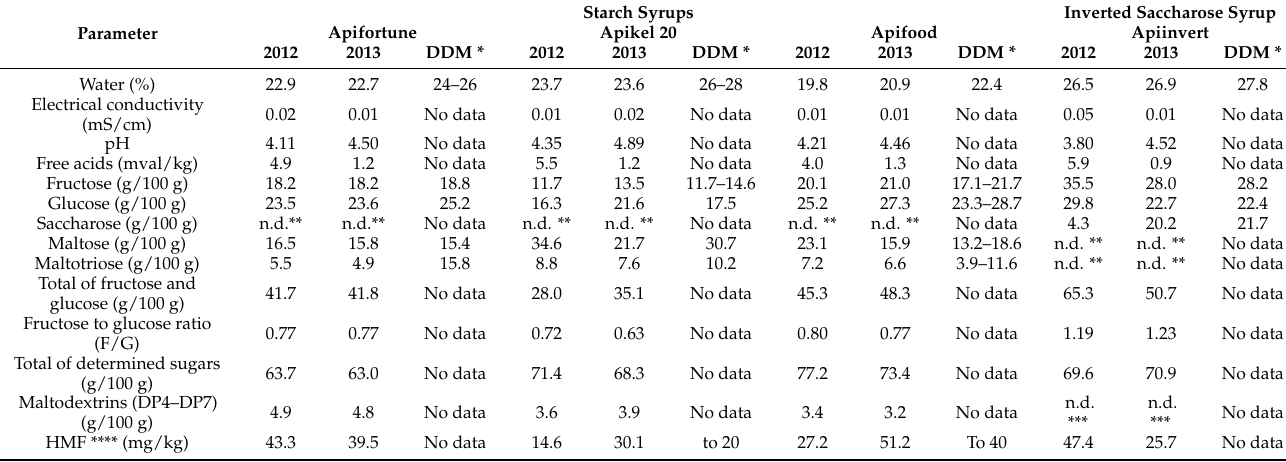
Table 1. Physicochemical parameters of starch syrups (Apifortune, Apikel 20, Apifood) and inverted saccharose syrup (Apiinvert).